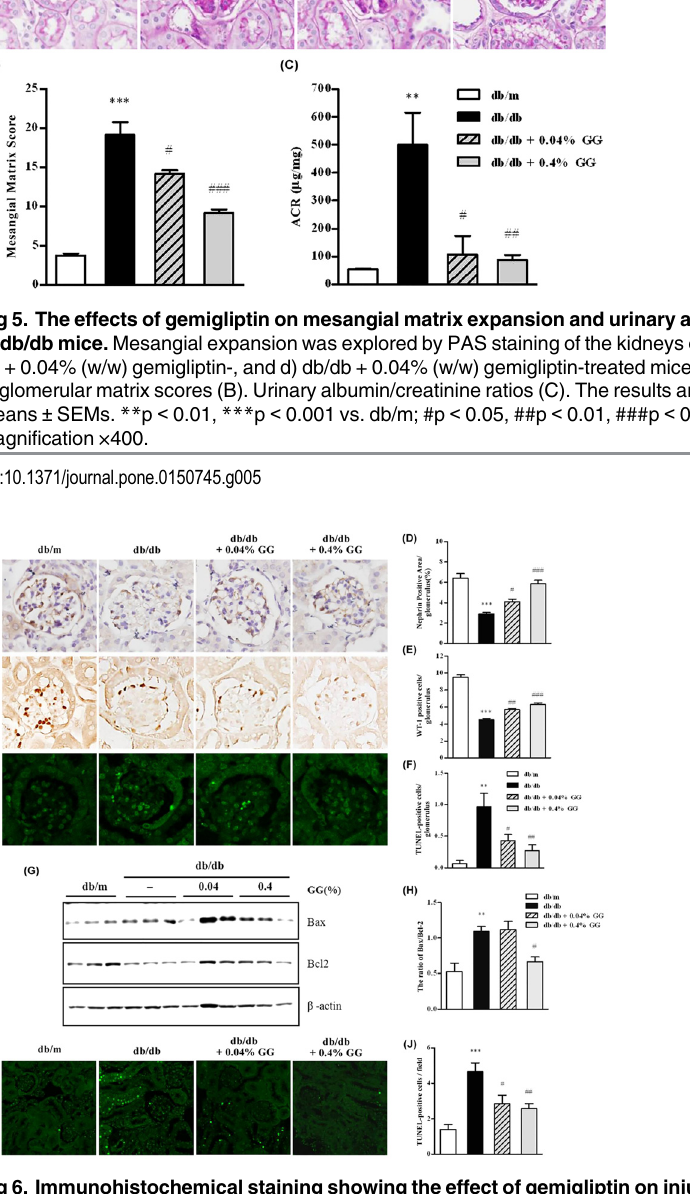
Fig 6. Immunohistochemical staining showing the effect of gemigliptin on injury to podocytes and apoptosis. Representative images of nephrin and WT-1 (A and C) and quantitative analyses of both nephrin and WT-1 levels (B and D) in db/m, db/db, 0.04% (w/w) gemigliptin-treated db/db, and 0.4% (w/w) gemigliptin-treated db/db mice. TUNEL staining detecting apoptotic injury to the glomeruli (E). Quantitative analysis of the numbers of TUNEL-positive cells (F) in the four experimental groups. Analysis of the levels of the pro-apoptotic Bax and anti-apoptotic Bcl2 proteins via Western blotting (G). TUNEL staining detecting injury to the kidney (H). Quantitative analyses of the numbers of TUNEL-positive cells and the Bax/Bcl2 ratios, derived using NIH ImageJ software, are shown for the four experimental groups (I and J). The results are expressed as means ± SEMs. ** p < 0.01, *** p < 0.001 vs. db/m; #p < 0.05, ##p < 0.01, ###p < 0.001 vs. db/db. Original magnification